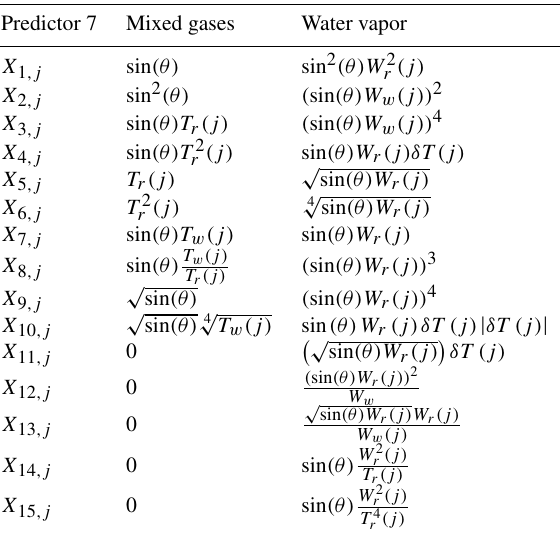
Table A1. Predictors 7 used for mixed gases and water vapor (after Matricardi et al.,